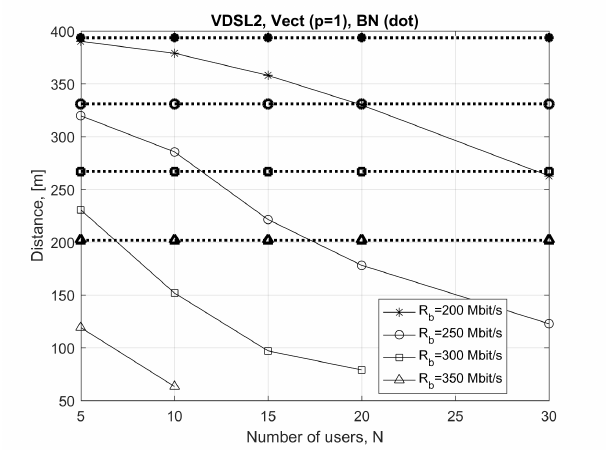
Figure 7. Maximum distance vs. number of users that can be served at a target bit rate R b , for the vectoring case p = 1, 5-th